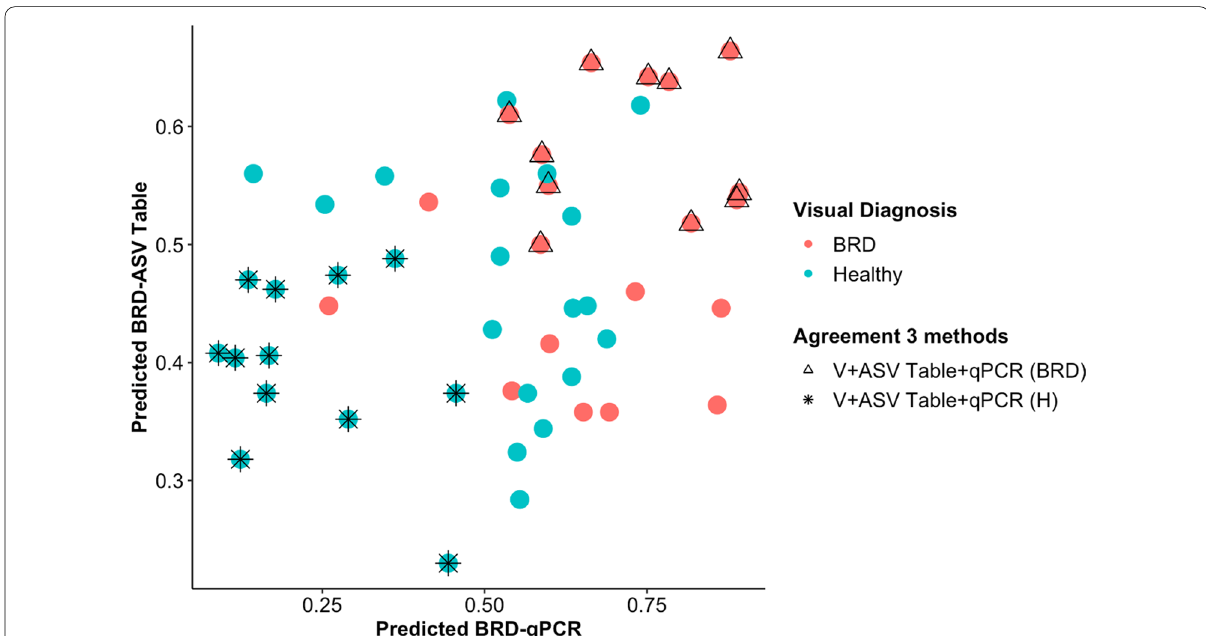
Fig. 6 Probability of classifying animals as BRD or healthy (< 0.5 healthy, > 0.5 BRD) using Random Forest analysis. Classification of the animals = = was based on the microbial community composition (ASV table) and quantification of BRD pathobionts, 16S rRNA gene abundance and age (qPCR). The color indicates the initial animal classification based on the BRD clinical signs. Shape indicates if the animal classification agreed between the three methods: visual classification based on BRD clinical signs (V), microbial community composition (ASV Table) and quantification of BRD pathobionts and 16S rRNA gene abundance